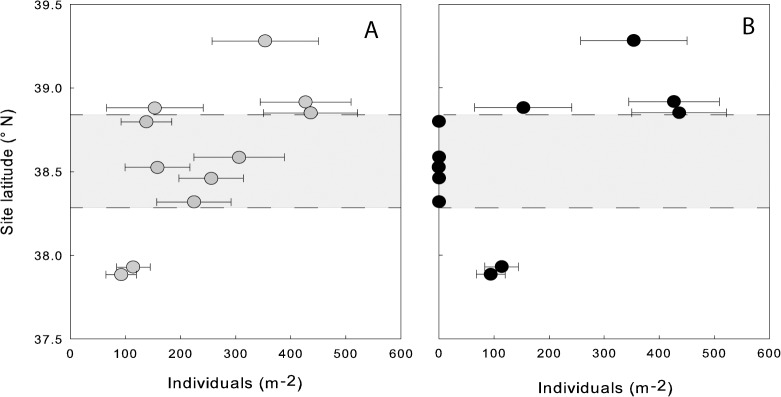
Densities of purple urchins (A) before and (B) after the mass mortality event, by latitude.Bars depict standard deviation across sampled quadrats. Data are from the 11 sites surveyed between September and December 2011 (sites 1–4, 6, 10, 14, 16, 18, 23, 24). The shaded area denotes the impacted region, in which we found zero individuals at all sites surveyed after the event (n = 5).